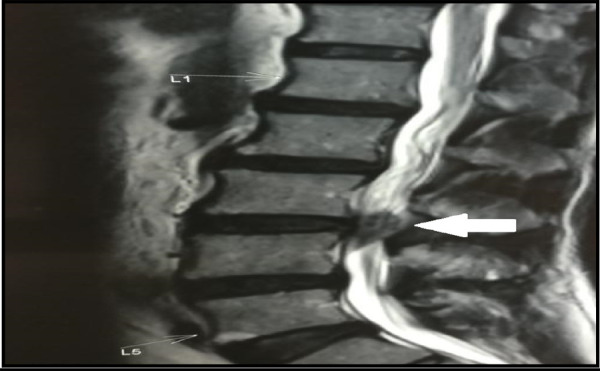
Postauricular fistulous opening of 1.5x 1.5 cm2.